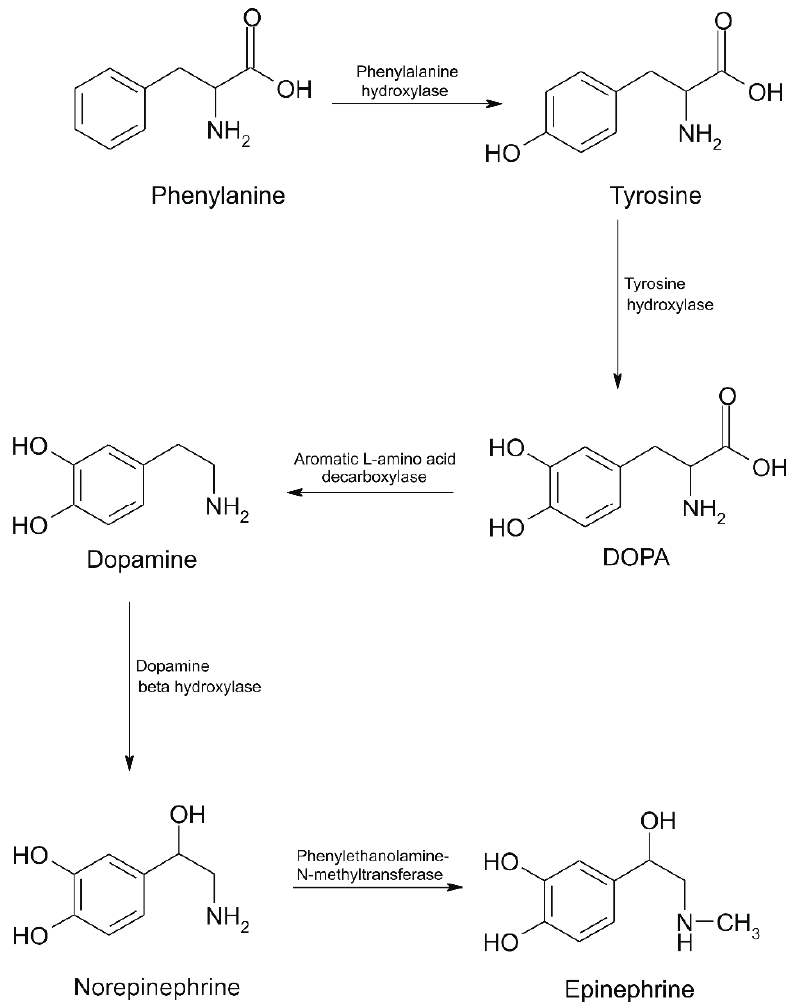
Figure 3. Phe conversion to epinephrine and other catecholamines [16].